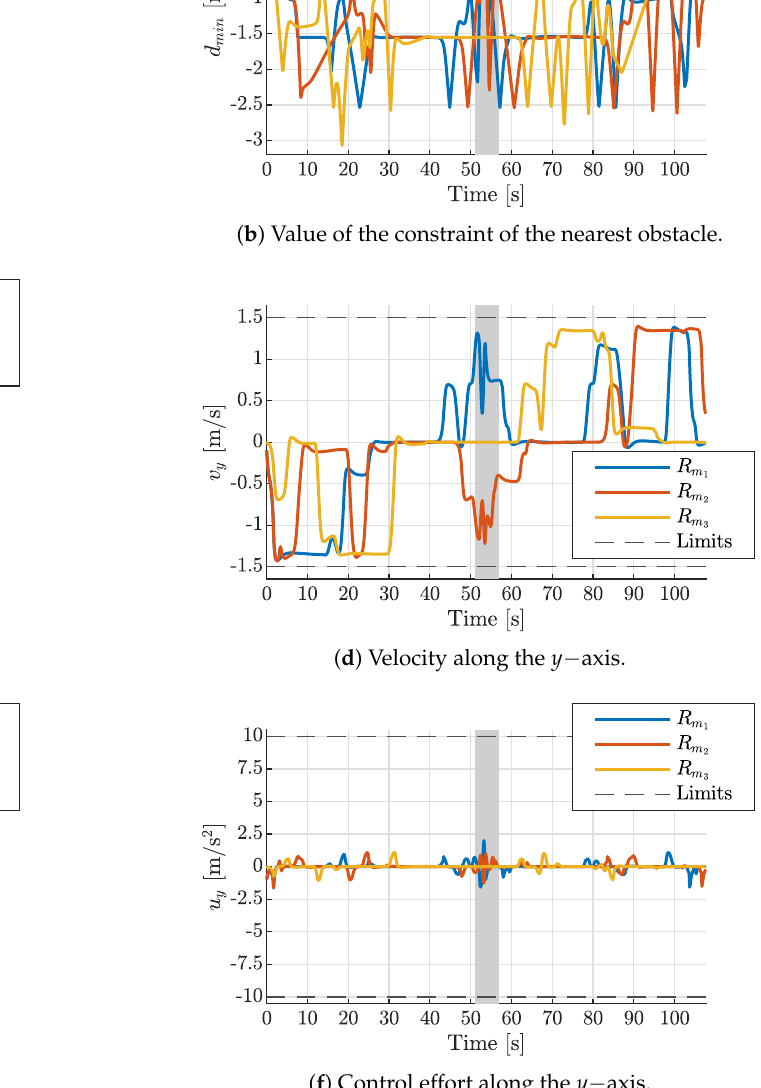
Figure 5. Simulation results. The shaded areas correspond to the avoided collision event described in Figure